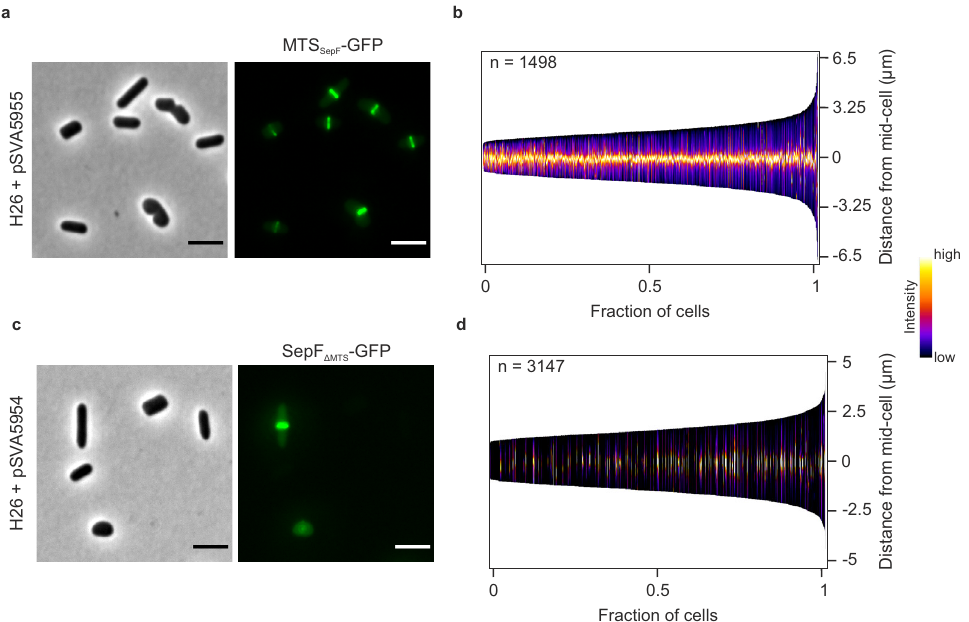
Fig. 2 Localization of only the membrane-targeting site of SepF and SepF without its membrane binding site. a Fluorescence microscopy of MTS SepF - GFP in H. volcanii cells during early exponential growth. b Demographic analysis of the GFP signal in the imaged cells shows localization of the GFP-tagged membrane-targeting site of SepF at midcell, independent of the cell length in all observed cells. c Fluorescence microscopy of SepF-GFP with the MTS of SepF deleted. d The construct was only expressed in 20% of the cells. However, in these cells SepF without MTS was localized at midcell regardless of the cell length. Both demographs summarize the results of three independent experiments per construct. Scale bars: 4 µ m.